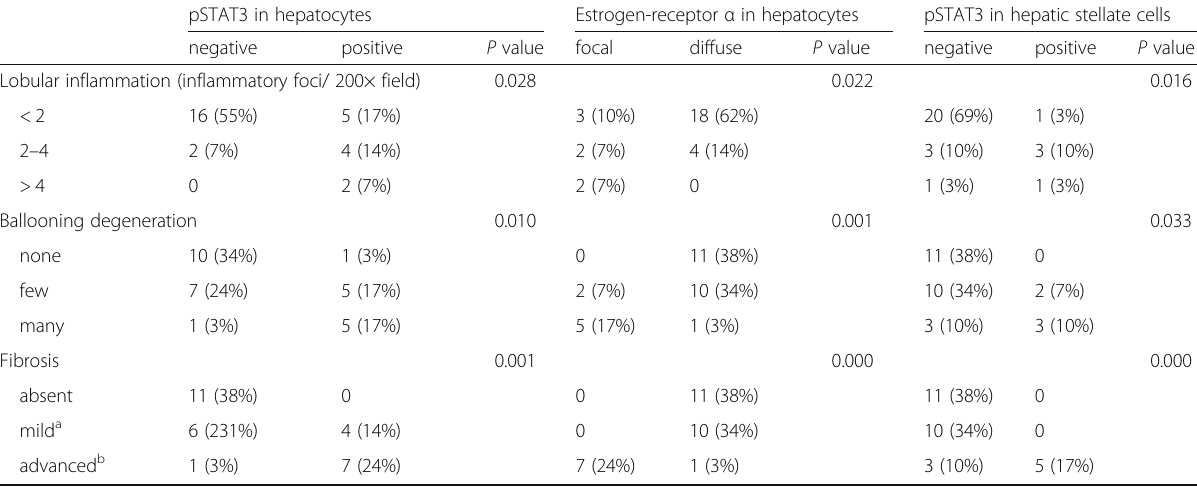
Table 3 Protein expressions related with histologic severity of hepatic steatosis pSTAT3 in hepatocytes Estrogen-receptor α in hepatocytes pSTAT3 in hepatic stellate cells negative positive P value focal diffuse P value negative positive P value Lobular inflammation (inflammatory foci/ 200× field) 0.028 0.022 0.016